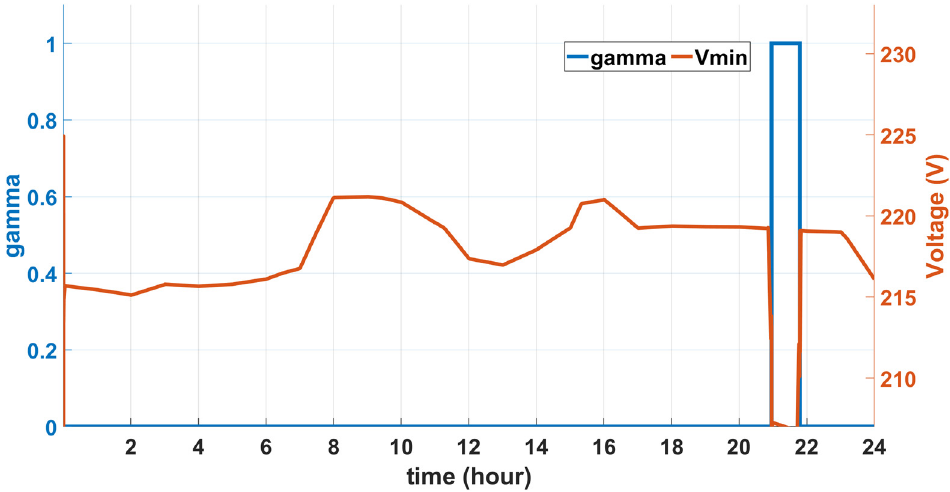
Figure 17. BUS voltage and signal 𝛾(𝑡) .